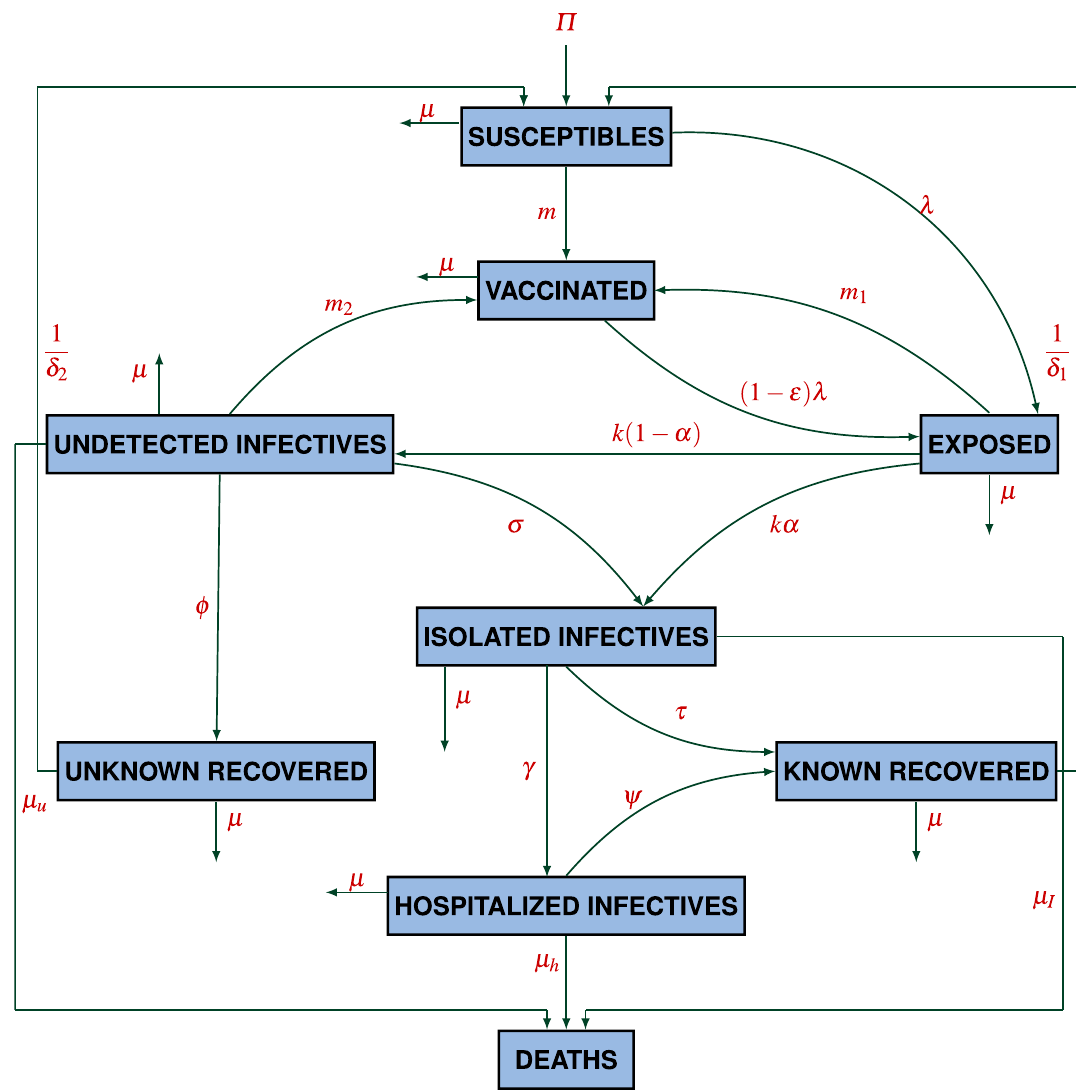
Figure 1. Schematic diagram describing the transmission of